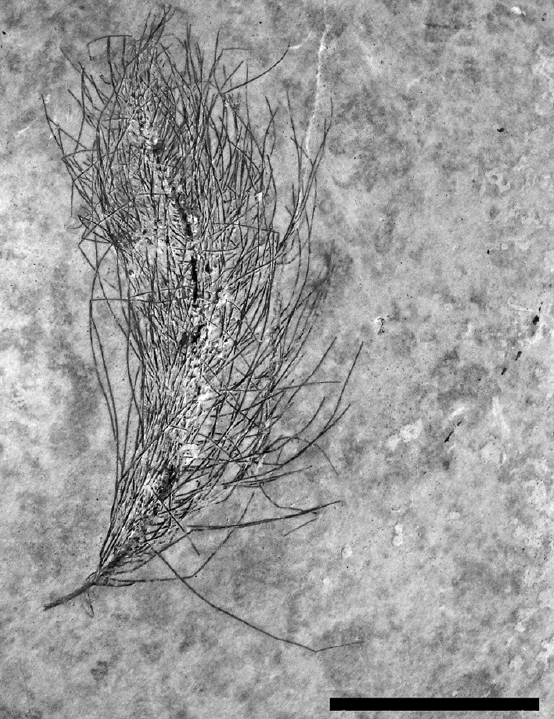
Fig. 5 – Fossil feather from Museu de Paleontologia de Santana do Cariri (MPSC – PN 2221), without barbules. Scale Bar 25